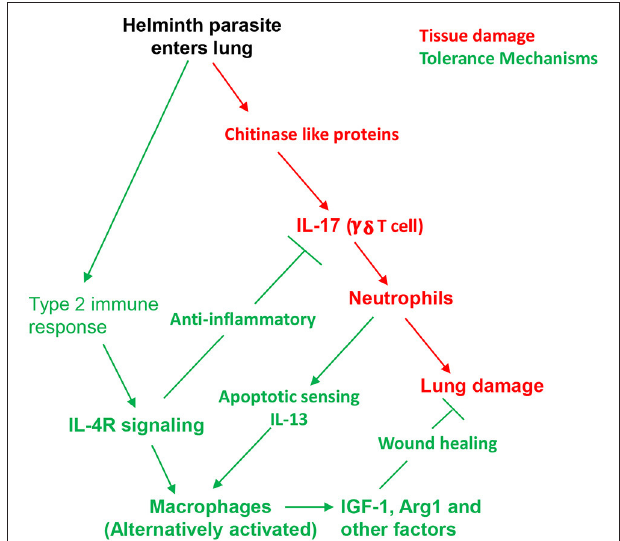
FIGURE 1 | Host tolerance mechanisms contribute to protective helminth-induced type 2 response by controlling lung damage. Invasion of the lung by N. brasiliensis L3 triggers release of chitinase-like proteins which stimulate IL-17 production by γδ T cells and consequent recruitment of neutrophils. Inflammation and physical damage of cells by migrating helminths result in acute lung injury. Within several days a potent type 2 immune response is also induced and tolerance mechanisms dependent on IL-4R signaling inhibit IL-17. Combined signals from neutrophils, lung surfactant protein A (SPA), and direct IL-4R signaling drives alternative macrophage activation, which contributes to both anti-inflammatory and direct wound repair